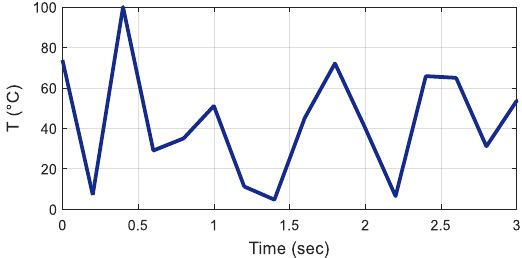
Figure 14. Variable temperature signal used for tests.